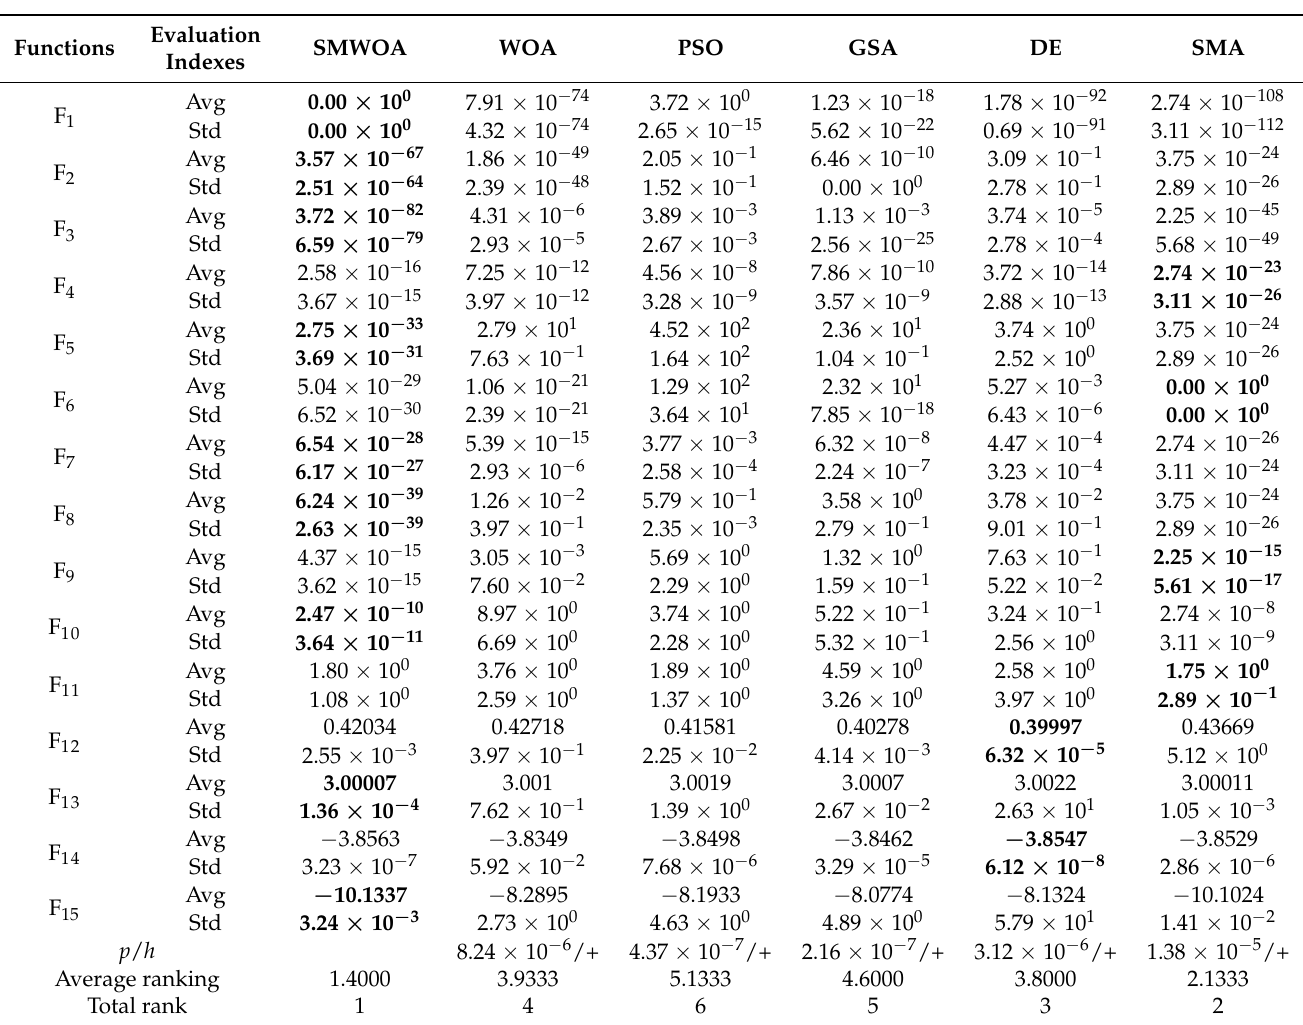
Table 3. Comparison of optimization